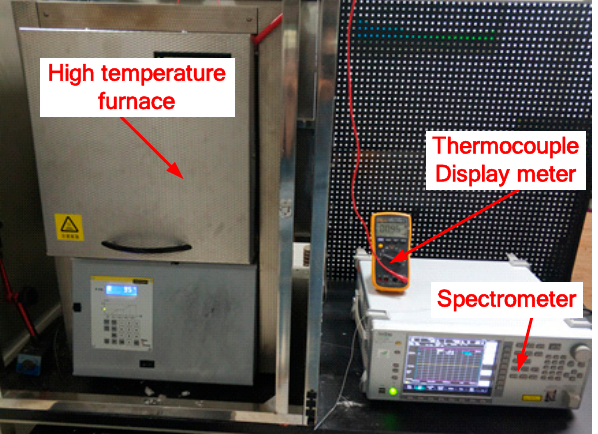
Figure 2. Static calibration experiment system of optical fiber infrared radiation sensor.